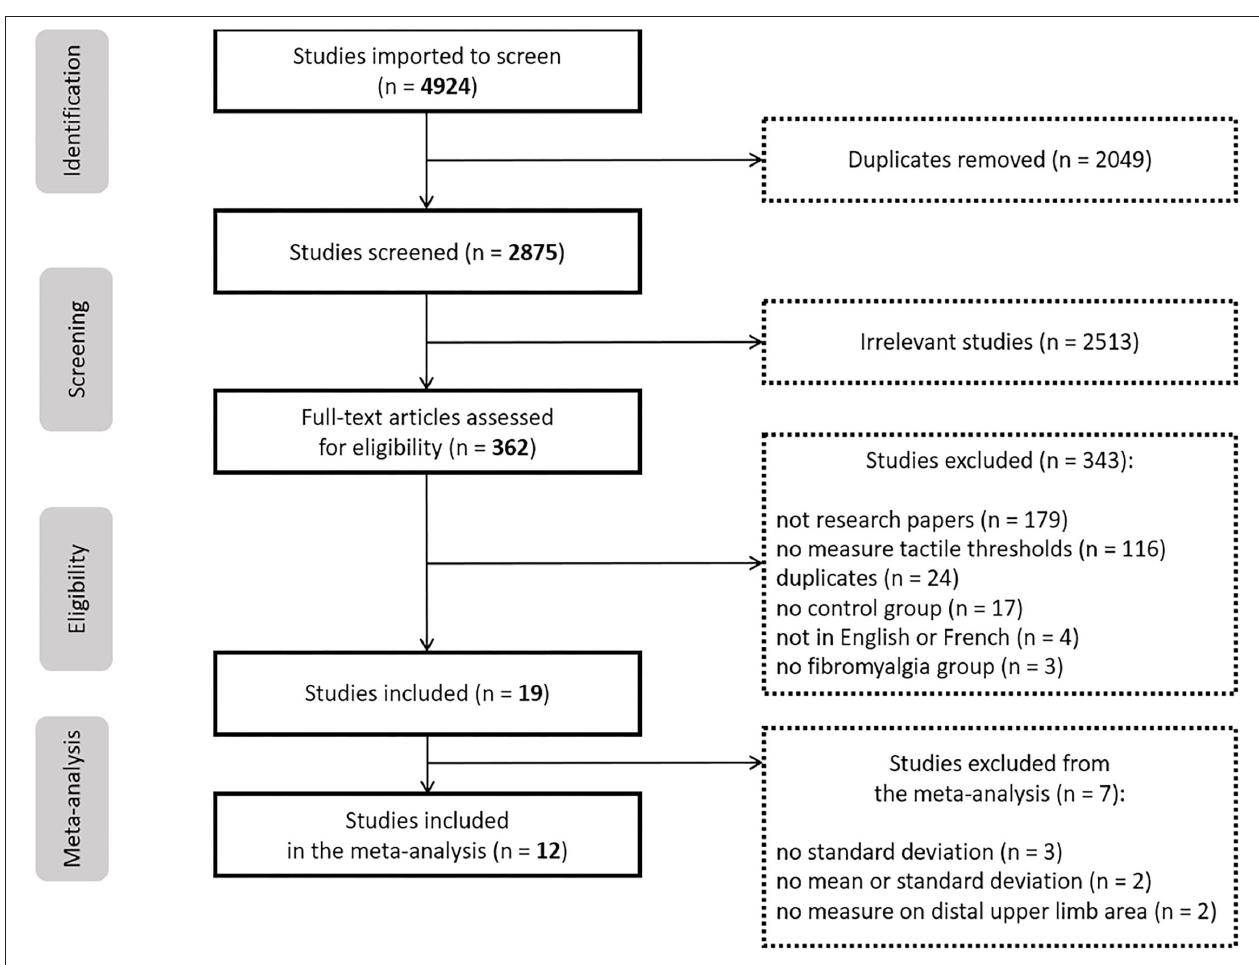
FIGURE 1 | PRISMA